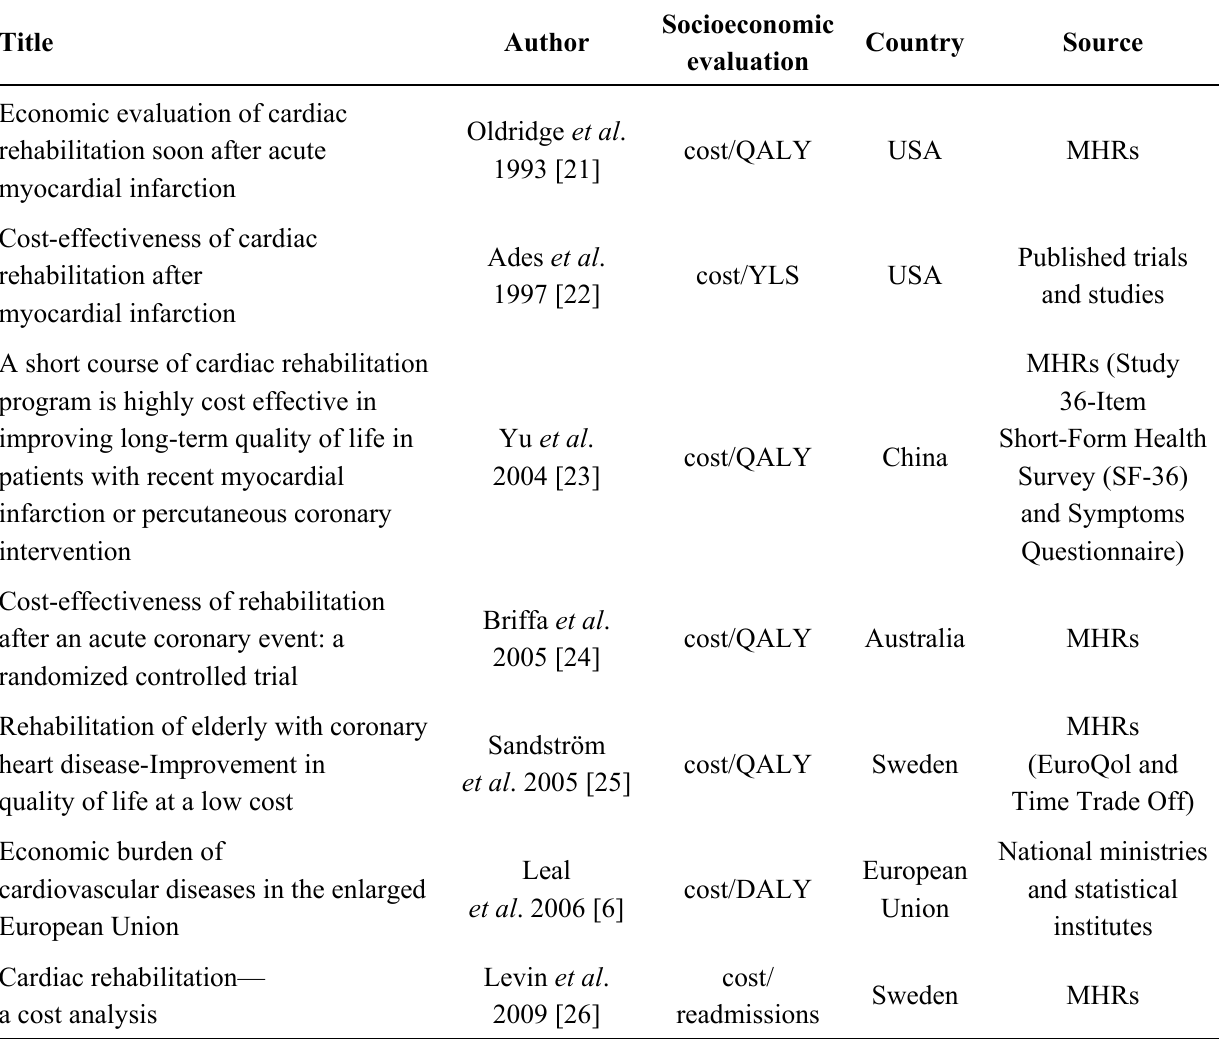
Table 1. State of the art in socioeconomic evaluations of cardiac rehabilitation after acute myocardial